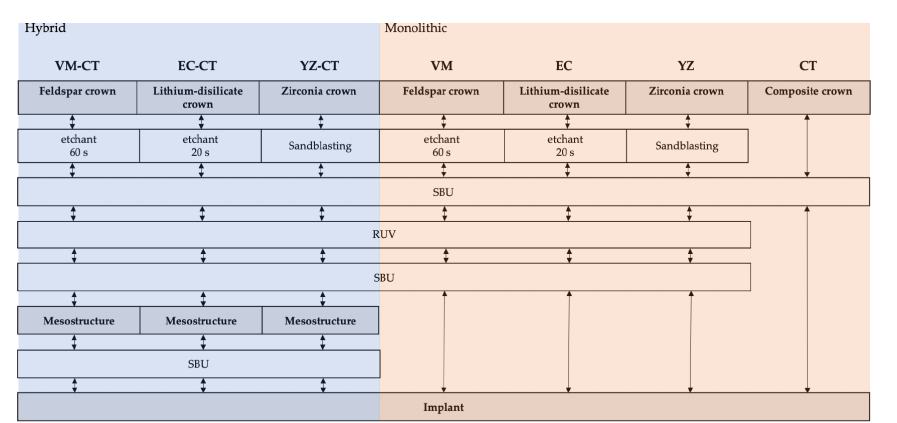
Figure 2. Test matrix describing the cementation procedure of mesostructures on implants and su- prastructures on mesostructures (Hybrid), as well as the cementation of monolithic crowns on im- plants (Monolithic).